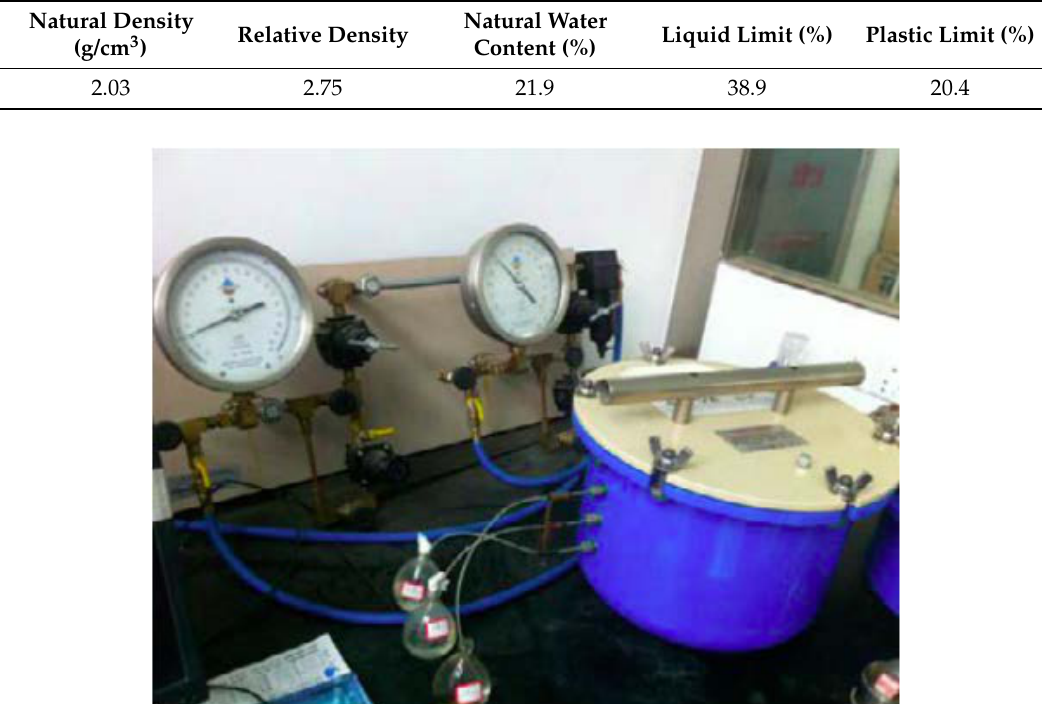
Table 1. The experiment was completed at the Institute of Rock and Soil Mechanics, Wuhan Institute of Chinese Academy of Sciences. The pressure plate instrument used in the experiment, which consists of pressure cell, higher air-entry value (HAE) ceramic disc, pressure gage, and nitrogen source, is shown in Figure 2. Table 1. Basic physical property index of Wuhan clay. Table 1. Basic physical property index of Wuhan clay.